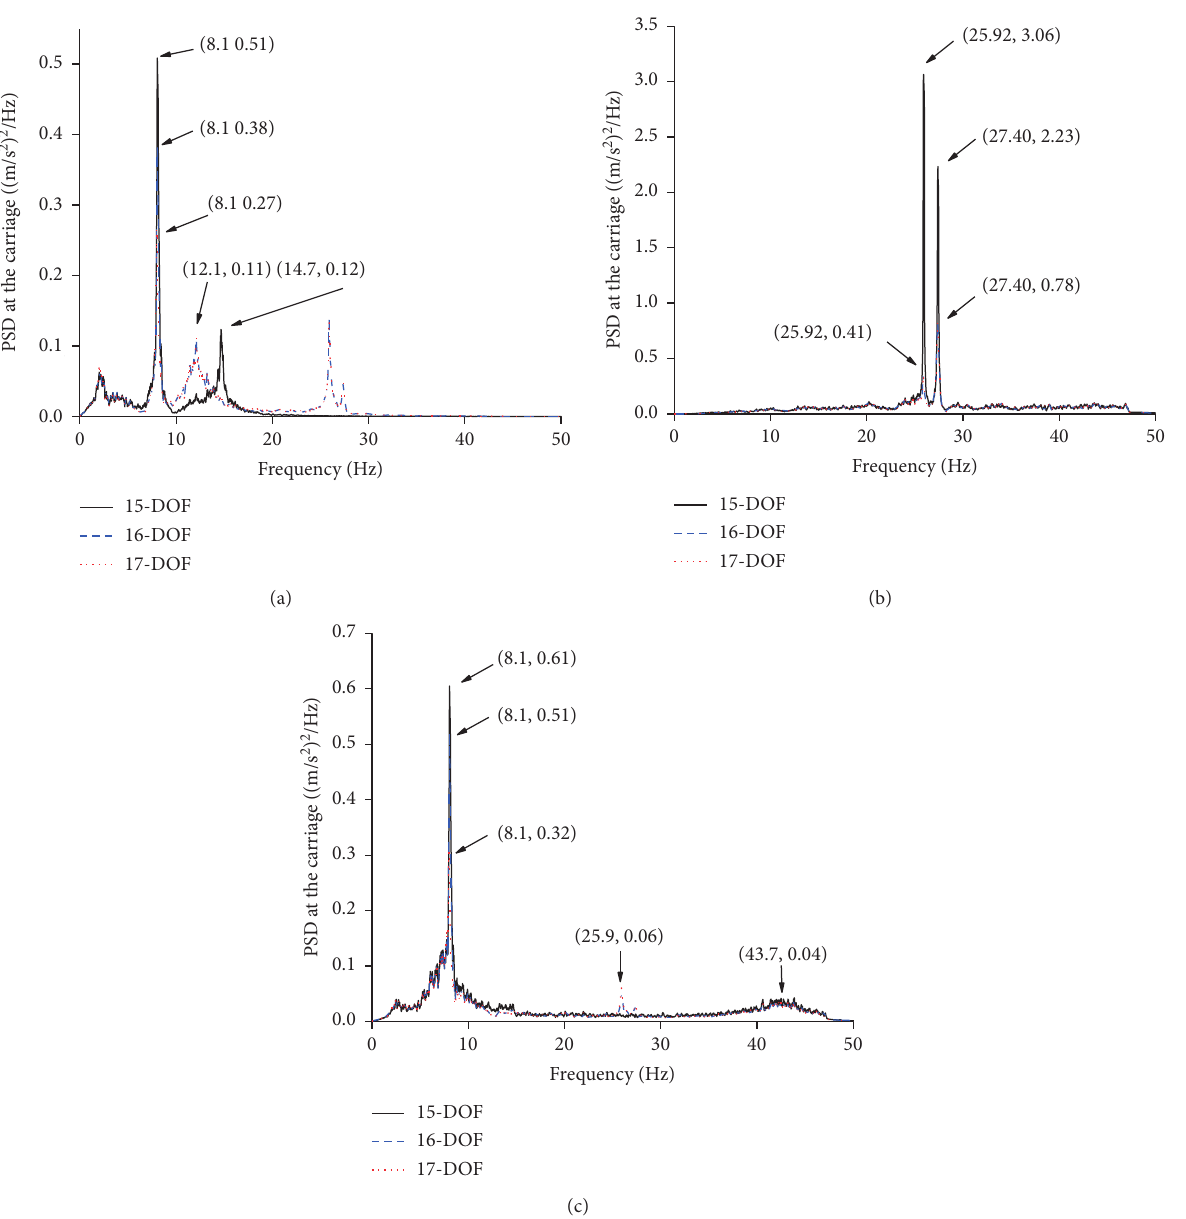
Figure 5: PSDs of the carriage vibration in (a) vertical, (b) roll, and (c) pitch